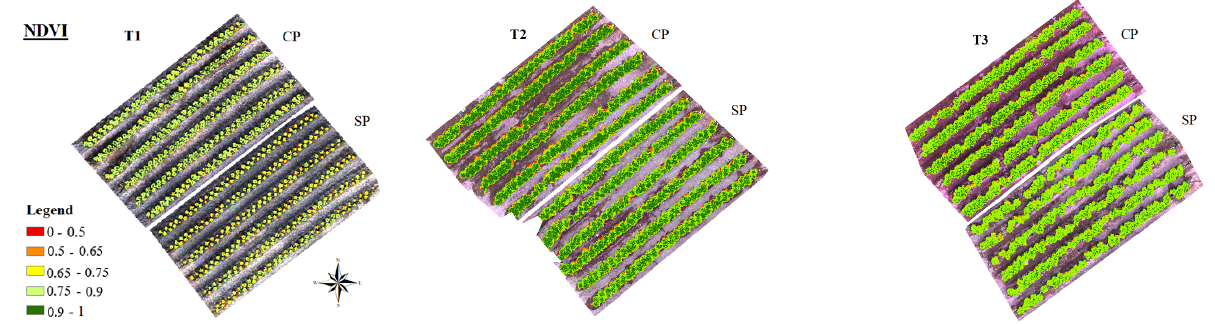
Figure 3. Maps of the NDVI applied to vegetation for T1, T2, and T3.